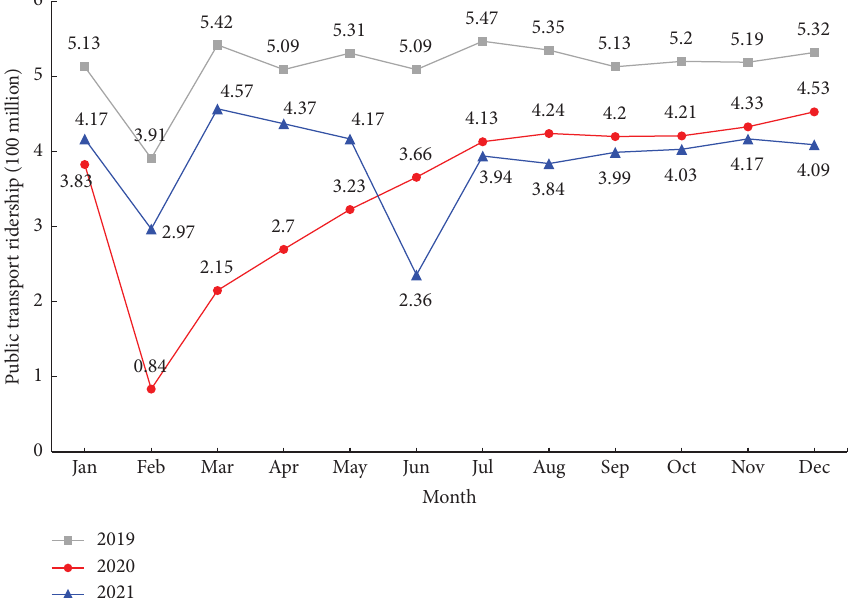
Figure 4: Public transport passenger volume of Guangzhou from 2019 to 2021 (monthly